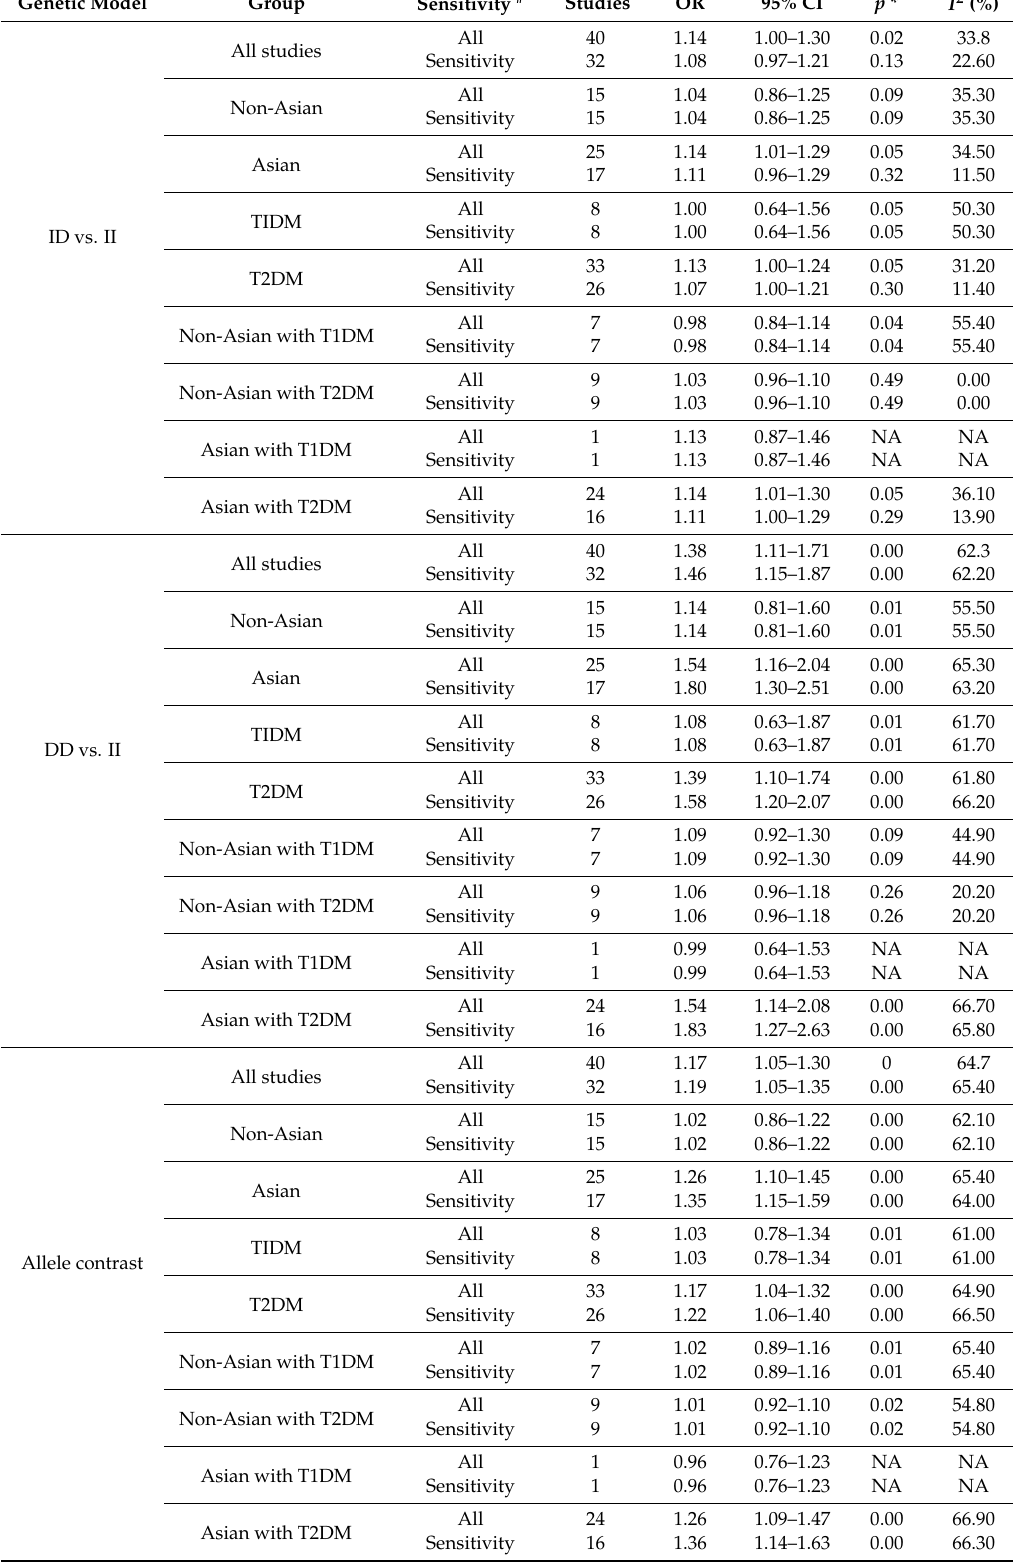
Table 3. Summary ORs and heterogeneity results for associations between the ACE I/D polymorphism and DR (diabetic